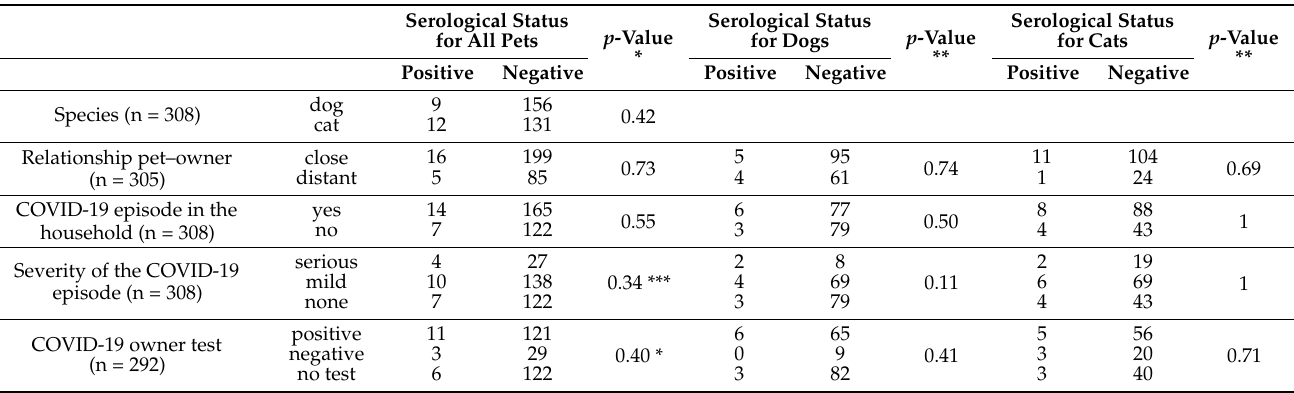
Table 1. Detailed information on dogs’ and cats’ serological status and risk factors in the household, in the univariable